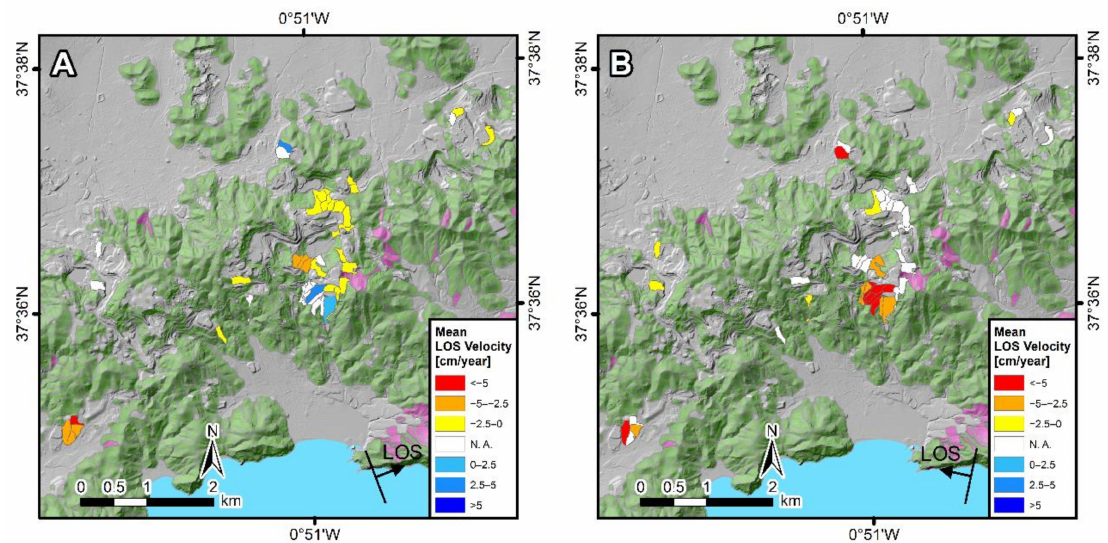
Figure 8. Mean LOS ground velocities obtained for the 43 active deformation slope units (ADSUs) from the optimal set (ADSU set 18). All ADSUs are represented in opaque (i.e., non-transparent) colors. ( A ) Ascending velocities. ( B ) Descending velocities. ADSUs not detected in each geometry are represented in opaque white. Unknown and stable SUs are also depicted in transparent pink and transparent green,